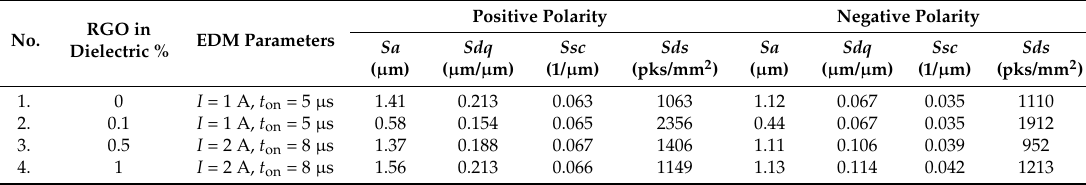
Table 2. The values of the machining parameters applied in the experimental